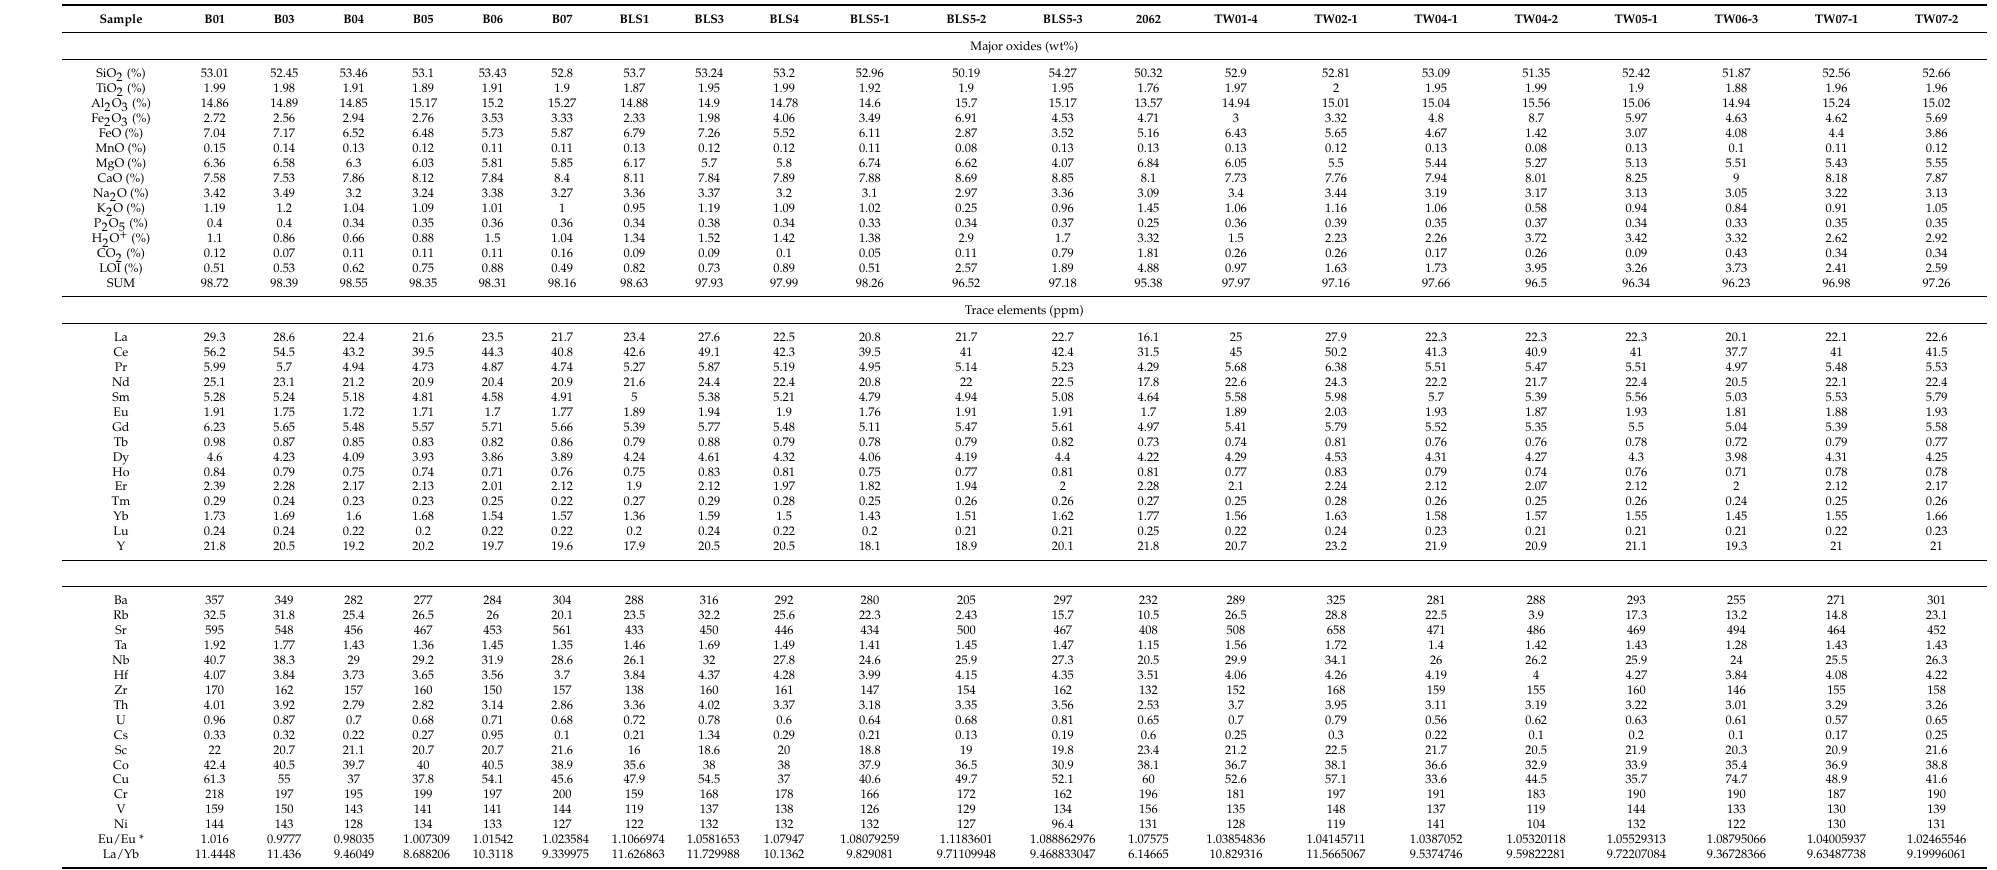
Table 1. Major and trace element compositions of the whole volcanic rock samples from Jiangling